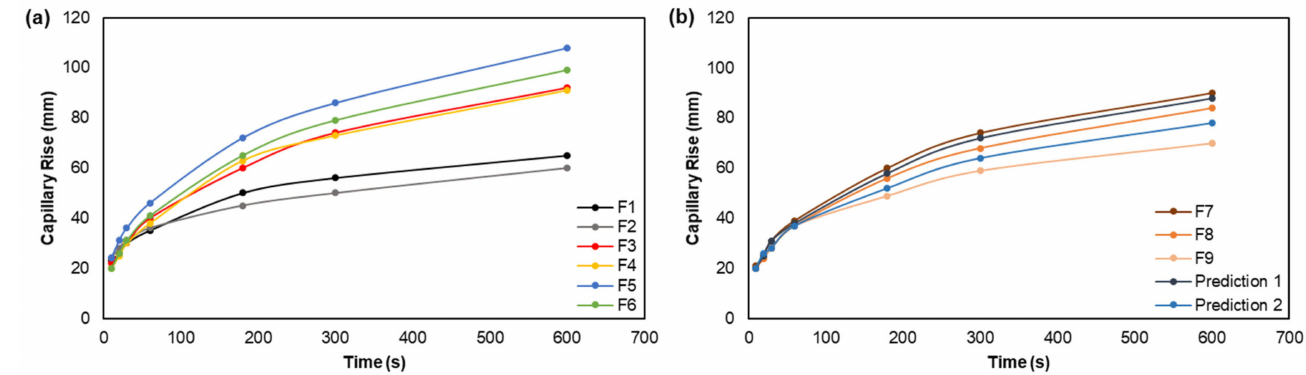
Figure 10. Evolution and prediction of capillary rise from F1 to F6 ( a ), and F7 to F9 ( b